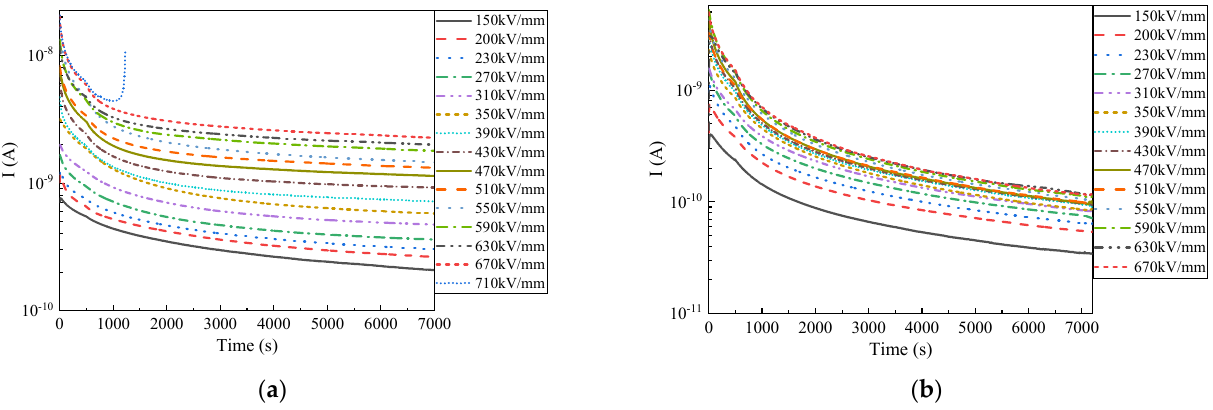
Figure 2. Charging and discharging currents of PP films. (( a ): The charging current versus time; ( b ): The discharging current versus time).